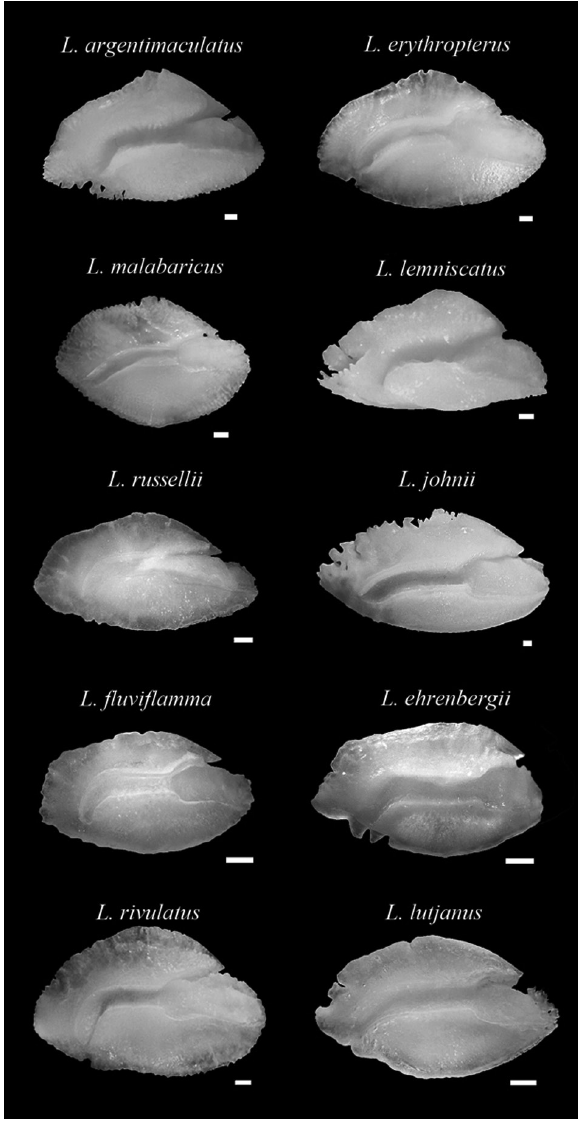
Fig . 2. – Sagittal otoliths of each species of snapper. Scale bars: 1